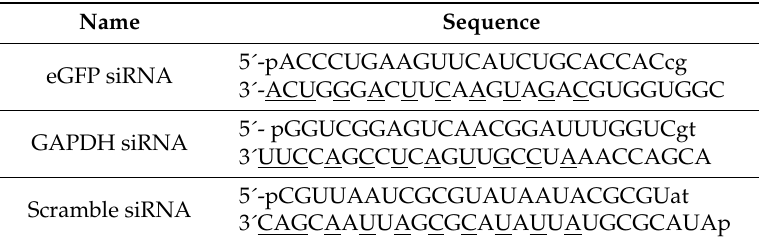
Table 1. Sequence of